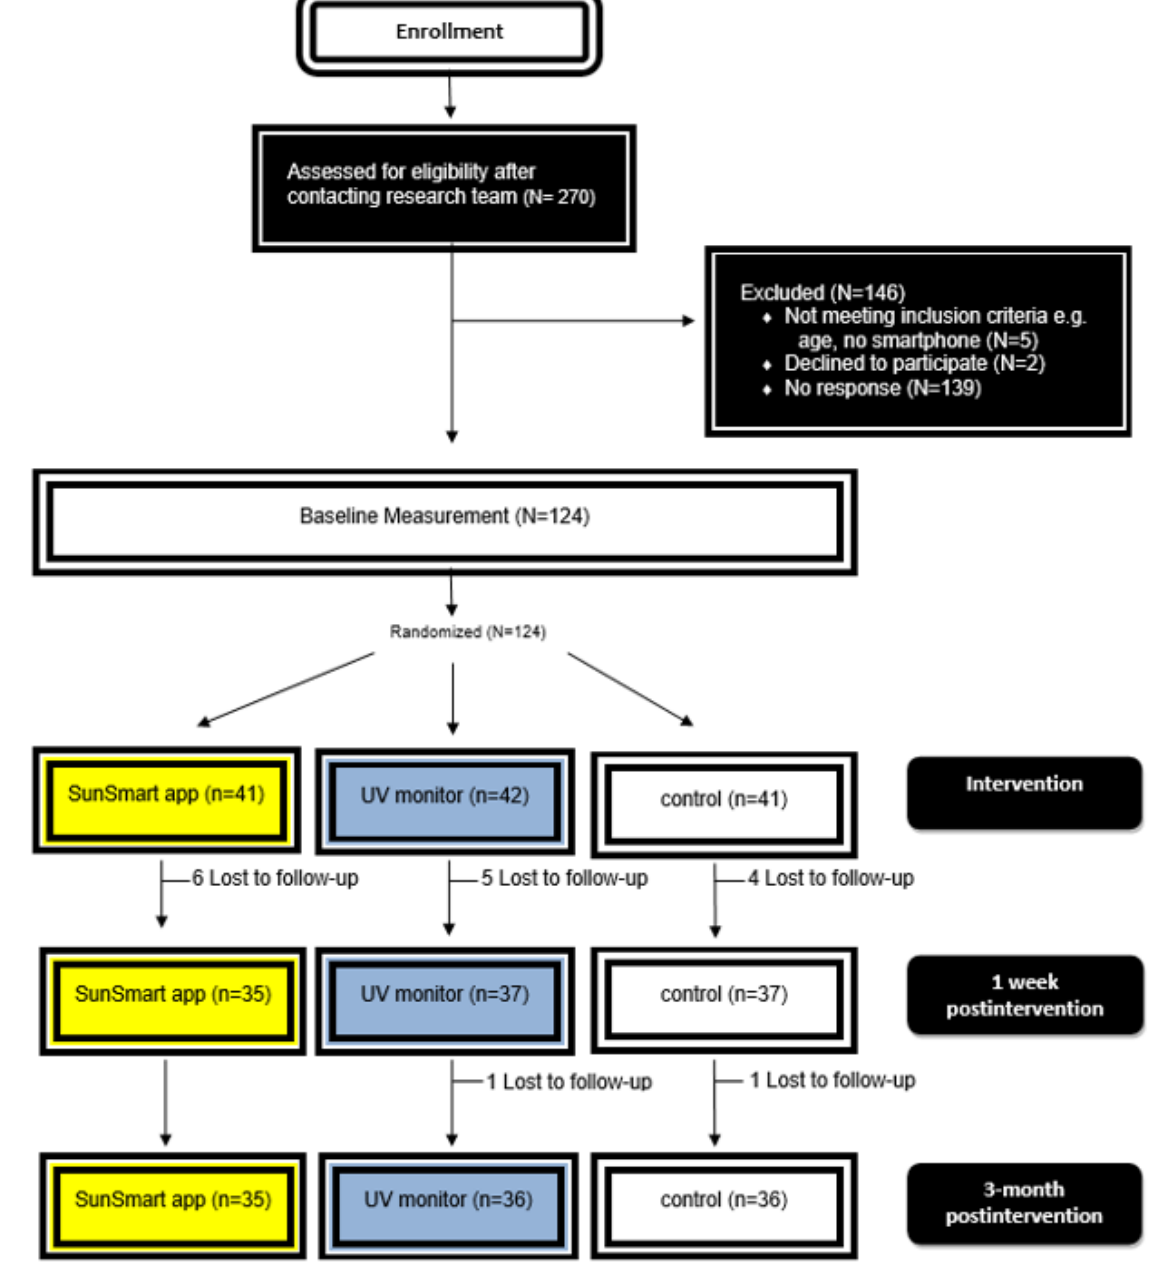
Figure 1. Flowchart of study recruitment. UV: